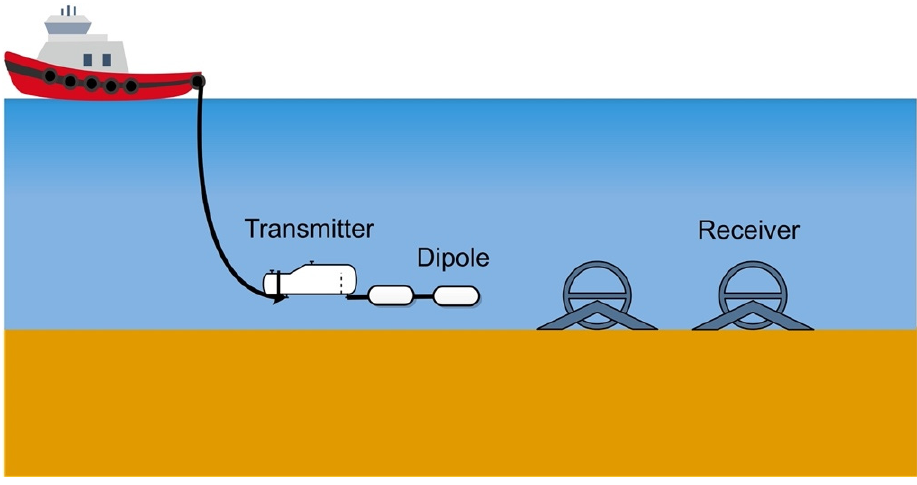
Figure 3. The towed source and seafloor receiver configuration.